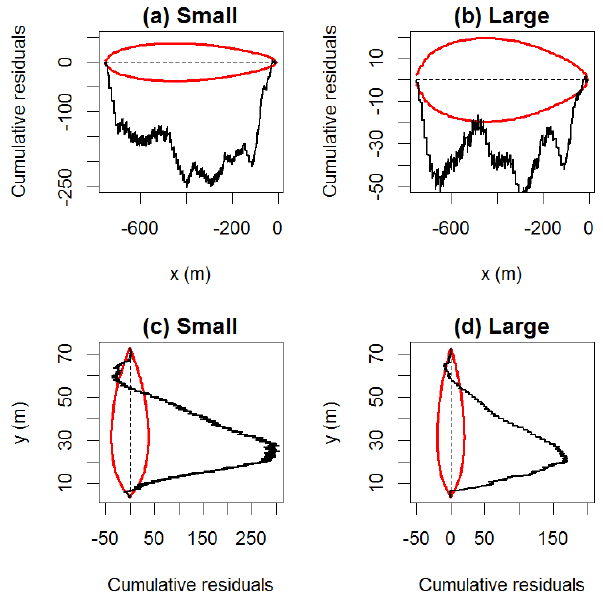
Figure 5. Lurking variable plots for the winter 2008 displaying the point process residuals (cumulative raw) under the assumption of complete spatial randomness against the x coordinate (alongshore distance) and the y coordinate (cliff elevation relative to NGF69 datum) for small erosion scars ( a and c ), and for large erosion scars ( b and d ). The empirical plot (solid lines) is shown together with the pointwise two-standard-deviation limits (red